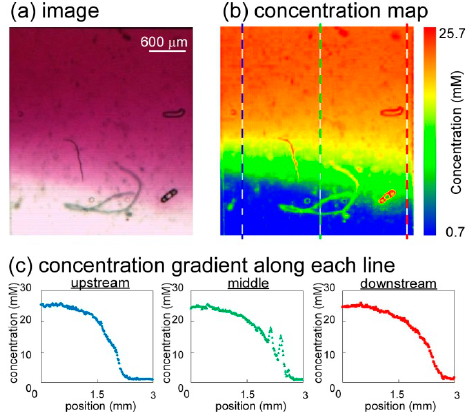
Figure 9. Map of the dye concentration in a united cell culture microchamber. ( a ) Image of the cell culture microchamber during gradient generation by using Nile red dye; ( b ) Map of the concentration of Nile red dye in the microchamber. The diffusion coefficient of the dye is nearly the same as that of glucose, meaning that the concentration of the dye is an accurate proxy for that of the glucose concentration; ( c ) Plot of concentration gradient along each line of upstream, middle and downstream.